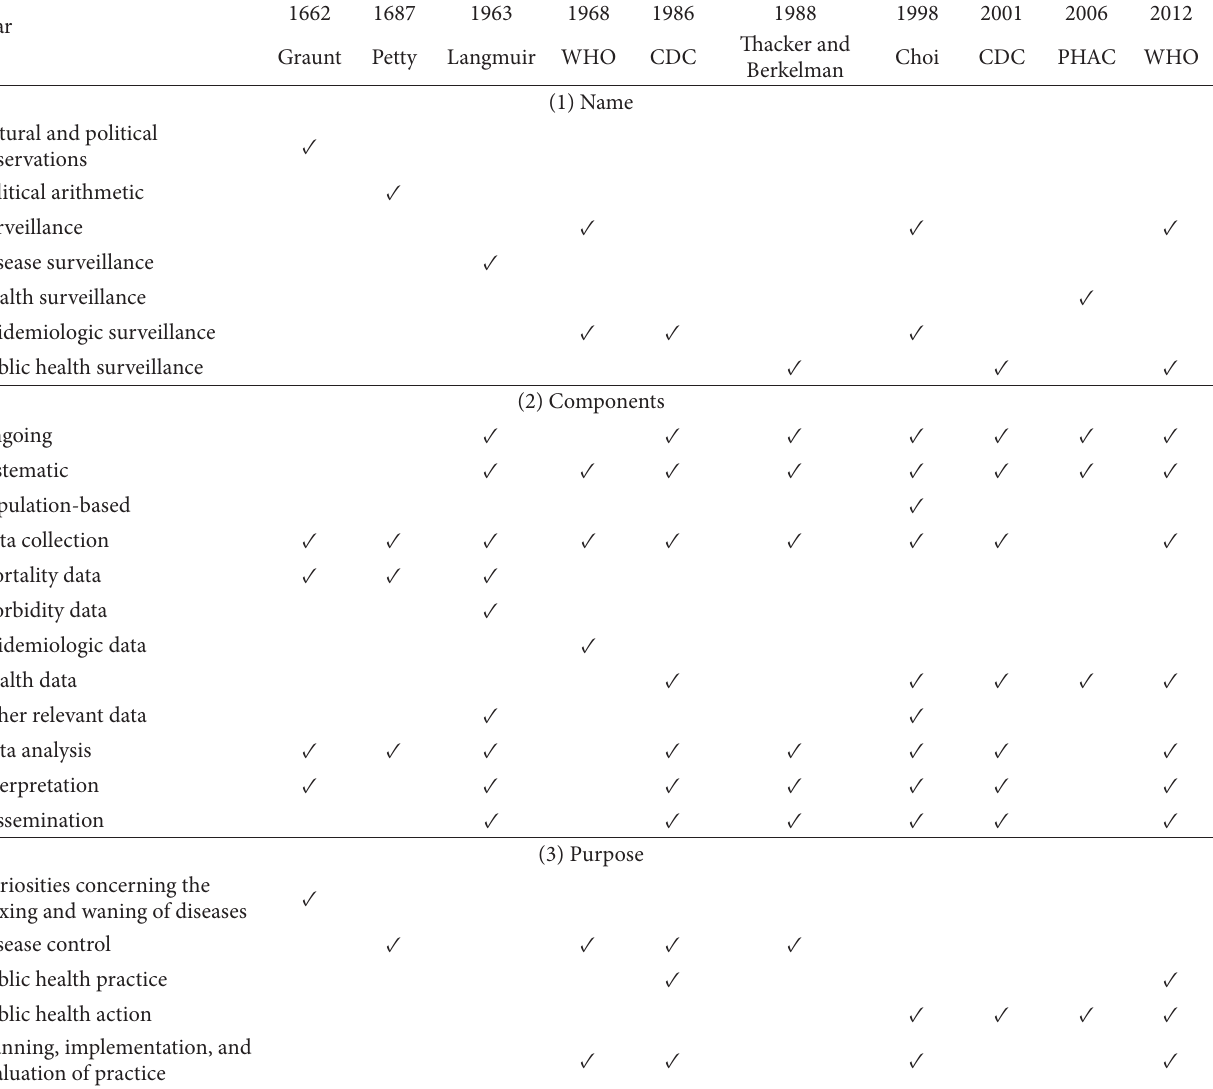
T 6: Comparison of de�nitions of public health surveillance over